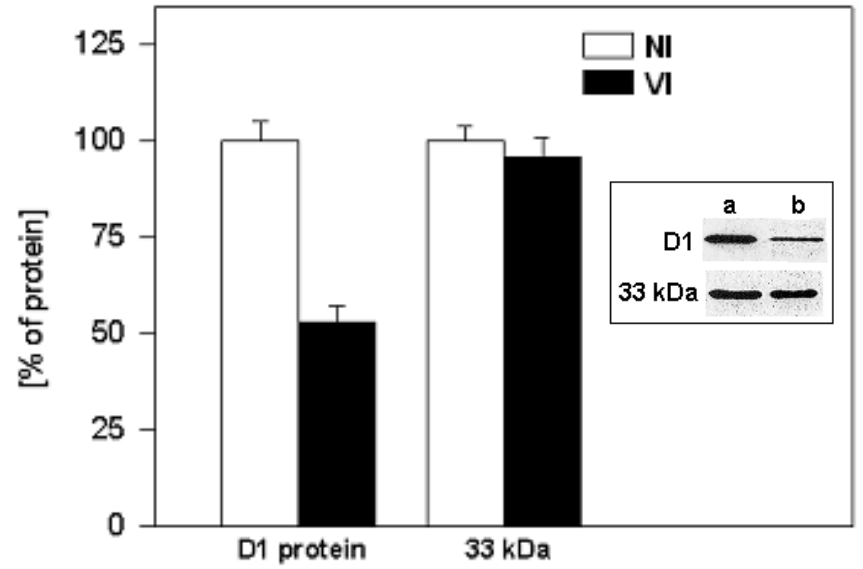
Fig. 5. Degradation of the D1 and 33 kDa proteins in thylakoids of noninfected (NI) and virus-infected (VI) Vitis vinifera leaves. Lane a, NI; lane b, VI. Each lane was loaded with equal amounts of Chl (5 µg). Histogram: Bio- Image densitometrical evaluation. Inset: